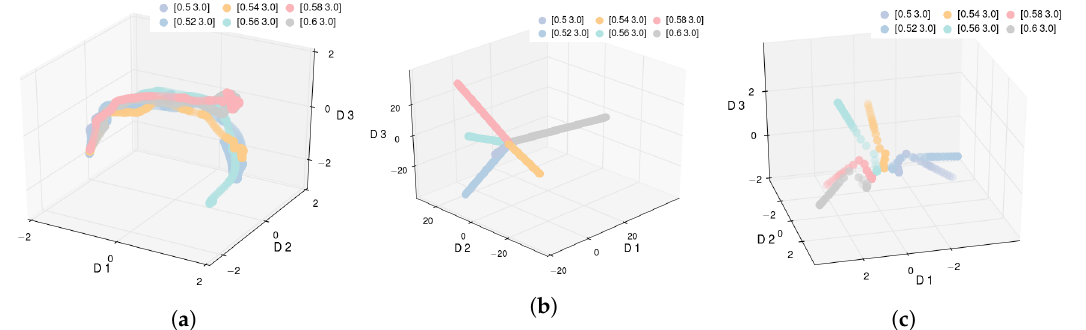
Figure 3. Low-dimensional ( d = 3) representation of six trajectories with fixed χ = 3.0 and variable φ ∈ { 0.50,0.52,0.54,0.56,0.58,0.6 } obtained using ( a ) PCA, ( b ) Isomap with k = 8, ( c ) Isomap with k = 8 using only the first 30 time steps of each pathway. (Please view in